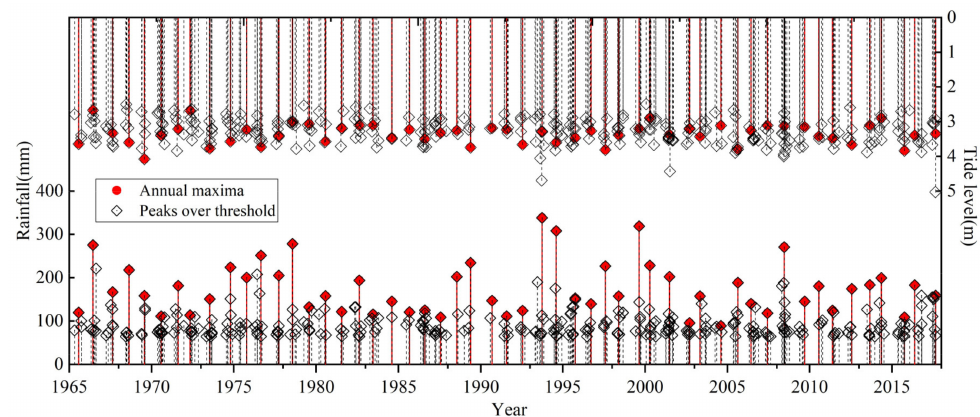
Figure 2. Extreme rainfall and corresponding high tide level series obtained using two sampling methods.